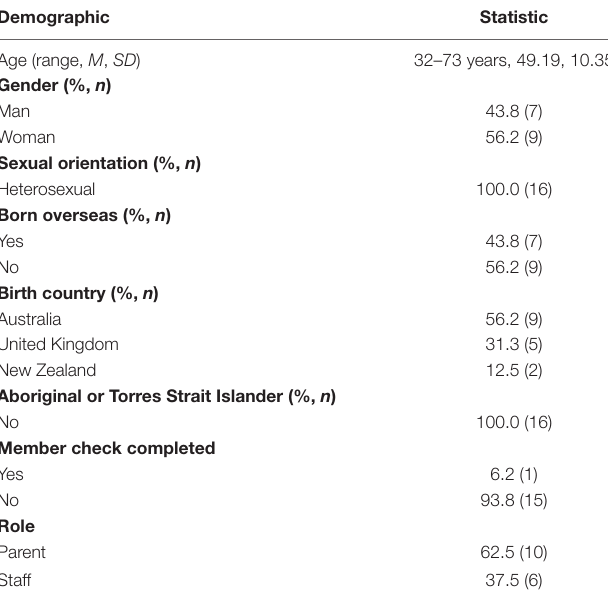
TABLE 1 | Summary of participant